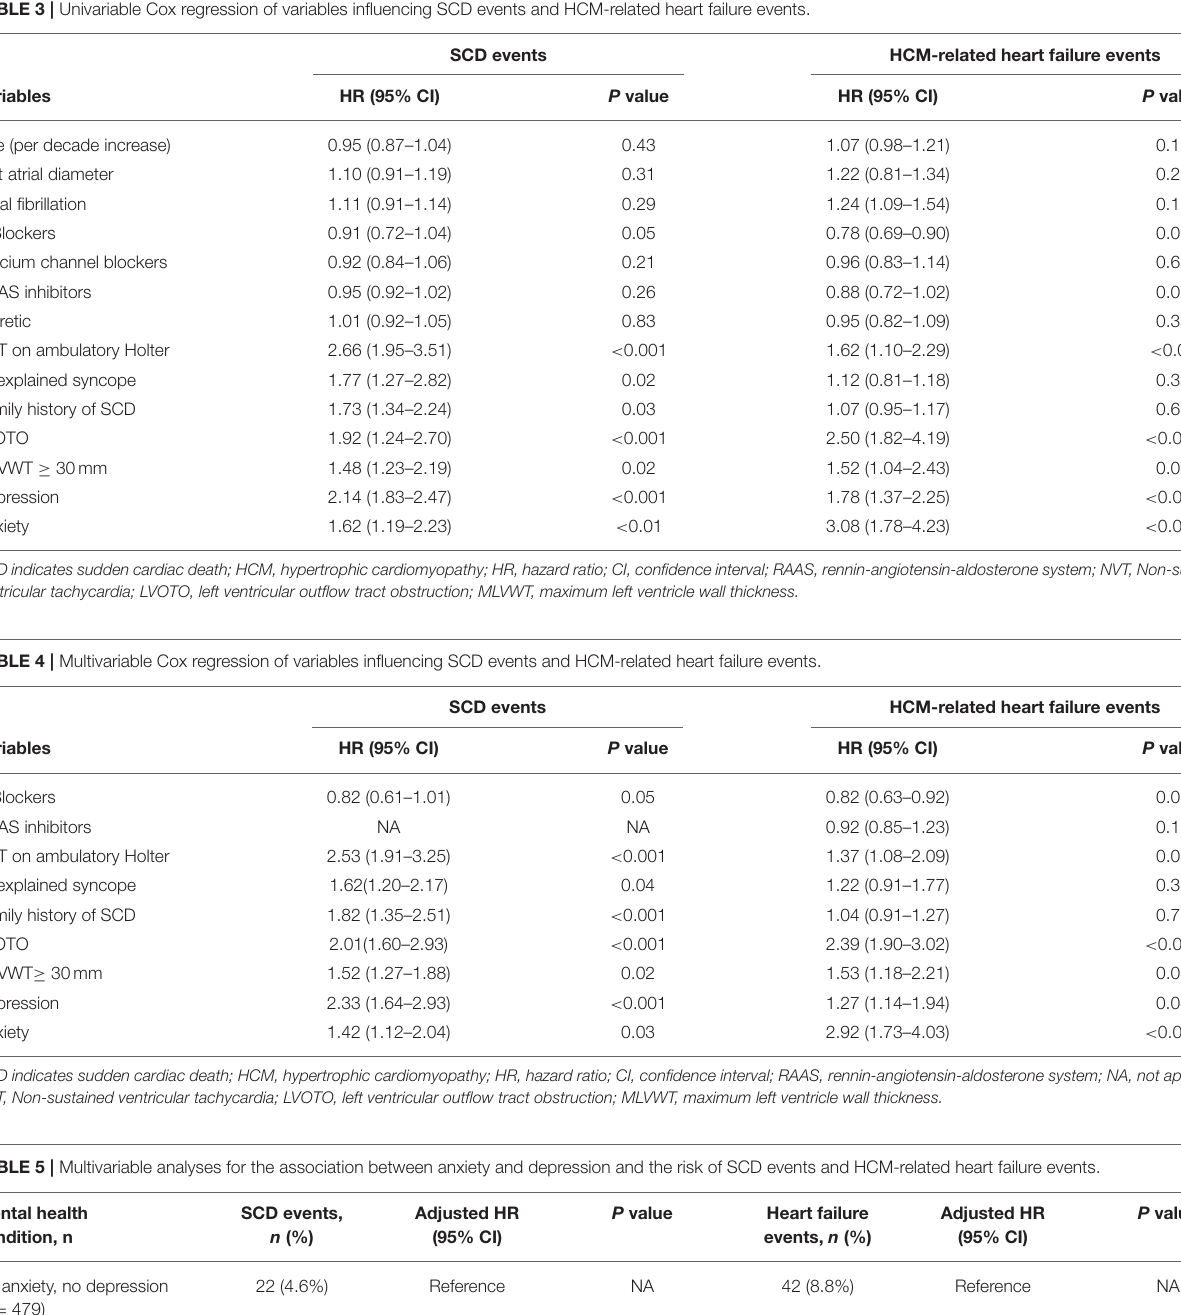
TABLE 3 | Univariable Cox regression of variables influencing SCD events and HCM-related heart failure events.